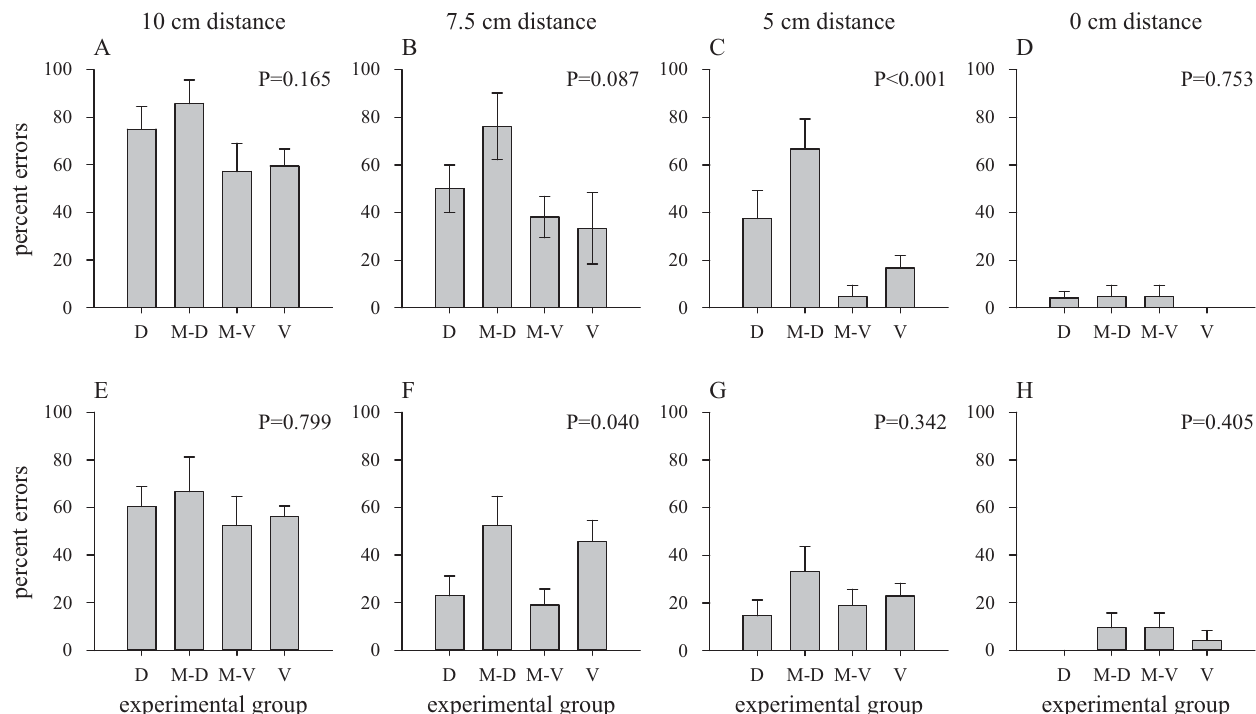
Figure 2. Decision accuracy at different distances to the search screen. The distance of the bee to the search screen has an effect on the error probability in all groups (D: ‘dorsal group’, M-D: flights of the ‘mixed group’ with targets located in the dorsal row, M-V: flights of the ‘mixed group’ with targets located in the ventral row, V: ‘ventral group’) during the first six foraging bouts ( A–D ) and during the last six bouts ( E–H ). The data show error percentages for four different distance to the search screen: 10 cm ( A, E ), 7.5 cm ( B, F ), 5 cm ( C, G ) and 0 cm ( D, H ). P values give the results of ANOVA comparisons between all four depicted groups. Bars: mean ± s.e.m., N=8 bees for the ‘dorsal group’, N=7 for the other groups (videos for the lateral-view camera were incomplete for some of the 9 tested individuals).